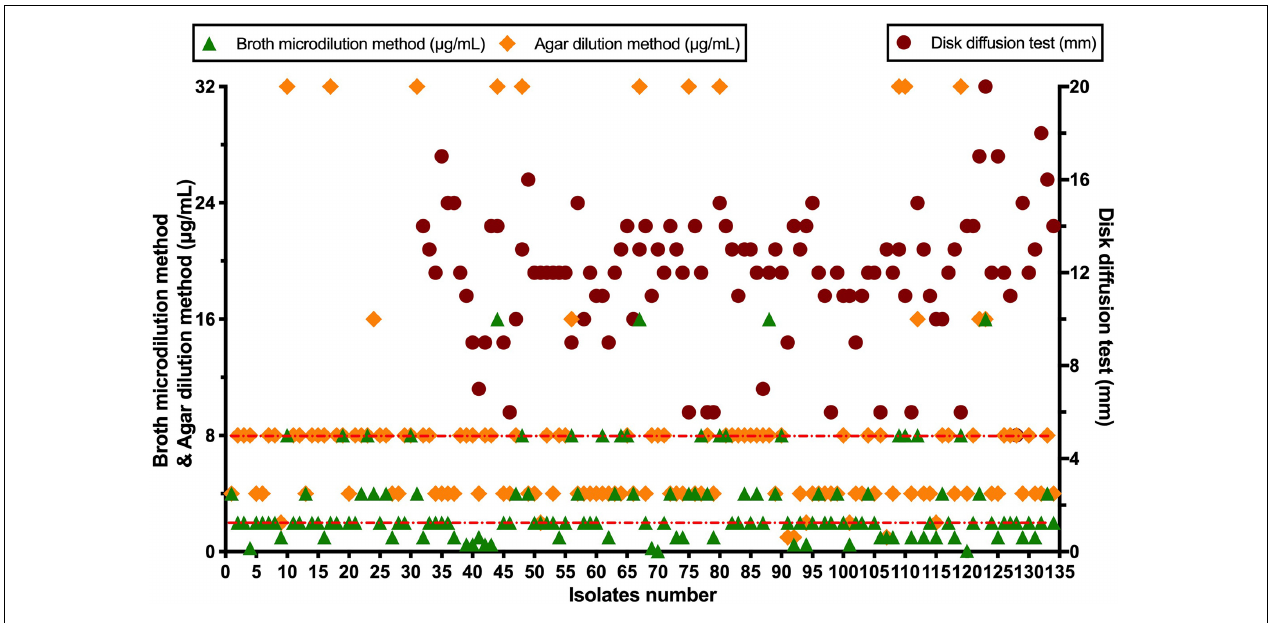
FIGURE 3 | Scatter diagram of tigecycline susceptibility